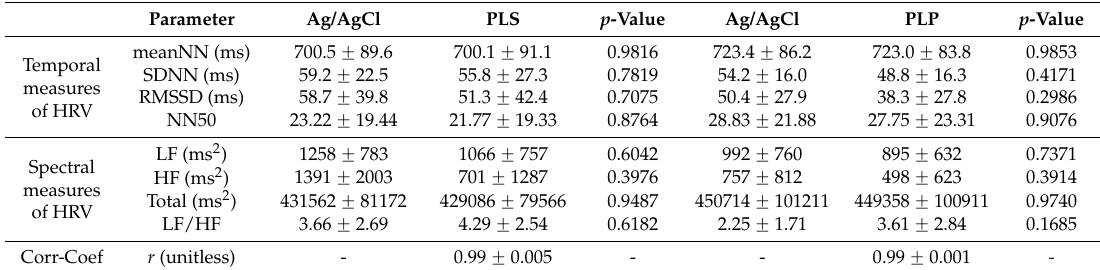
Table 2. Electrocardiogram signal quality—dry condition.